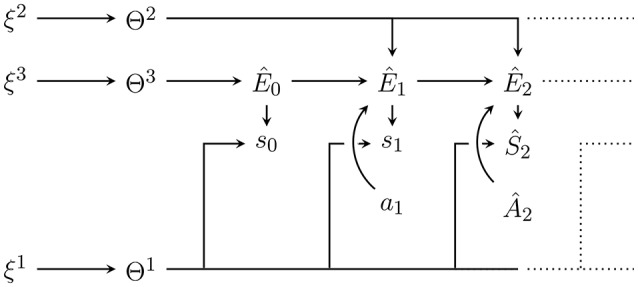
Internal generative model with plugged in data up to t = 2 with Ŝ0 = s0, Ŝ1 = s1 and Â1 = a1 as well as from now on fixed hyperparameters ξ = (ξ1, ξ2, ξ3). Conditioning on the plugged in data leads to the posterior distribution q(ŝt:T^,ê0:T^,ât:T^,θ|sa≺t,ξ). Predictions for future sensor values can be obtained by marginalising out other random variables e.g., to predict Ŝ2 we would like to get q(ŝ2|s0, s1, a1, ξ). Note however that this requires an assumption for the probability distribution over Â2.